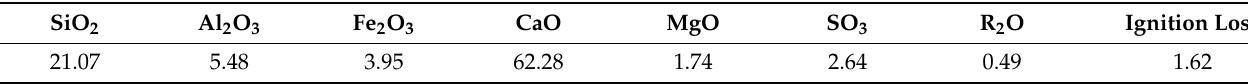
Table 2. Chemical composition of cement (wt.%).